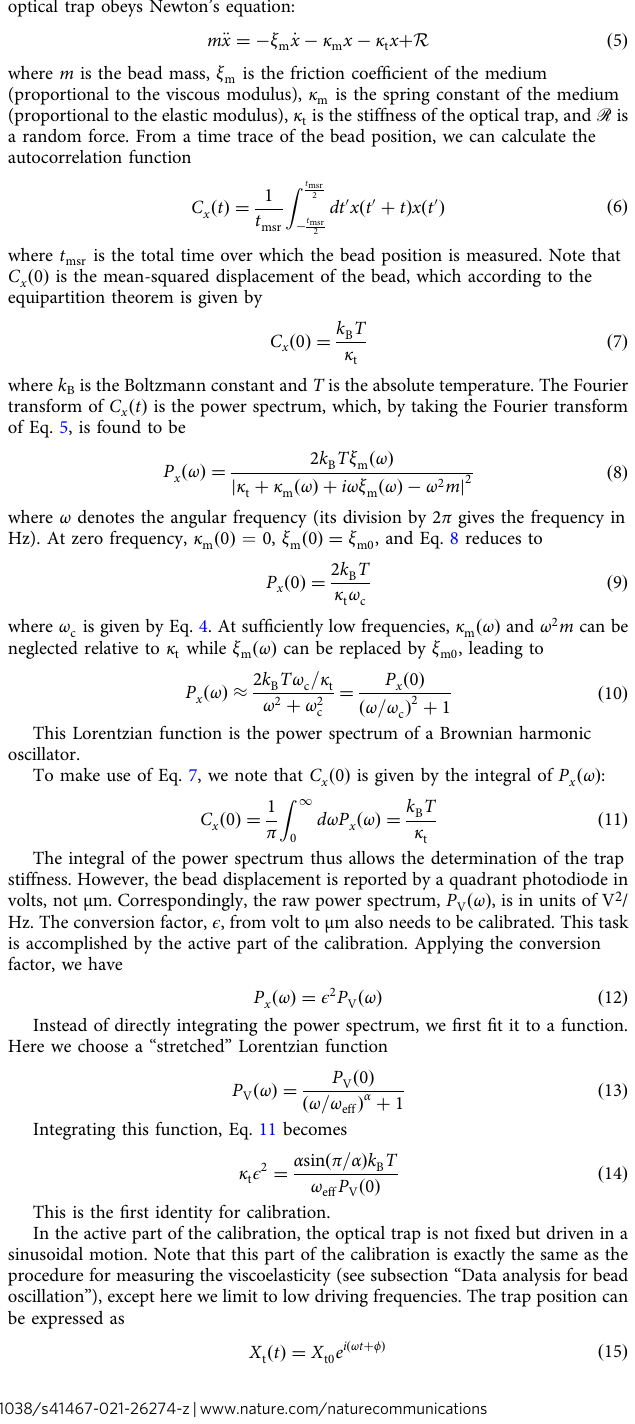
(and interfacial tension) yields information on energetic proper- ties of macromolecular components, measurement of shear relaxation moduli enables us to probe dynamic properties of these molecules. Similar to fusion, other condensate dynamic processes, including shape recovery after deformation, physical association of different condensates, multiphase organization, assembly and